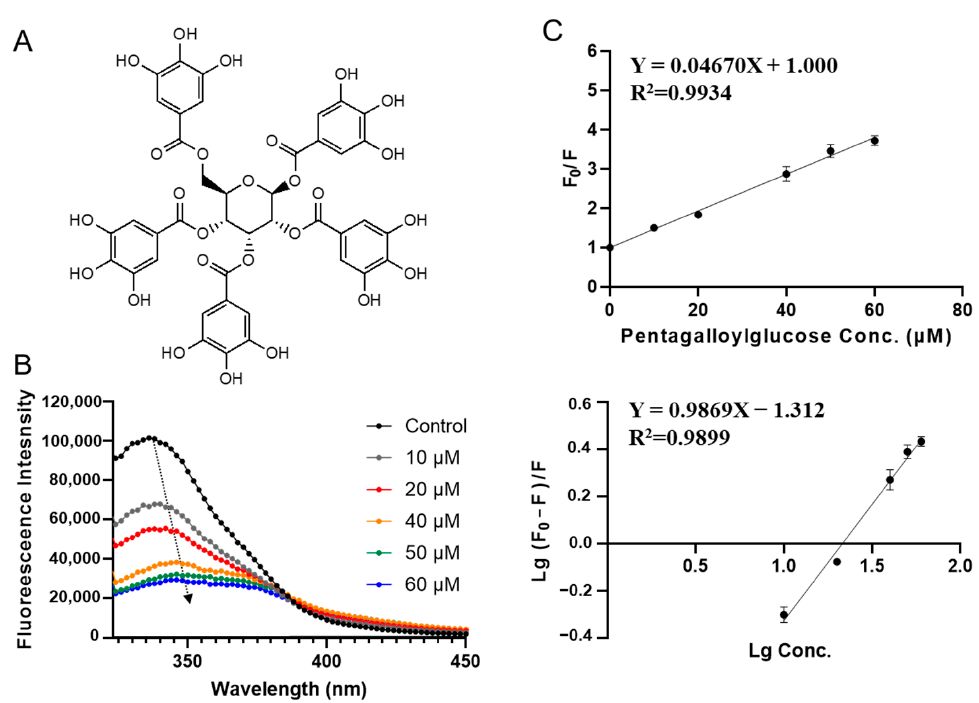
Figure 3. Characterization of SPI–pentagalloylglucose interaction by fluorescence quenching assay. ( A ) Molecular chemical structure of pentagalloylglucose. ( B ) The fluorescence emission spectra of SPI titrated with different concentrations of pentagalloylglucose (10, 20, 40, 50, 60 µ M). ( C ) The Stern–Volmer plots for binding parameter calculation.